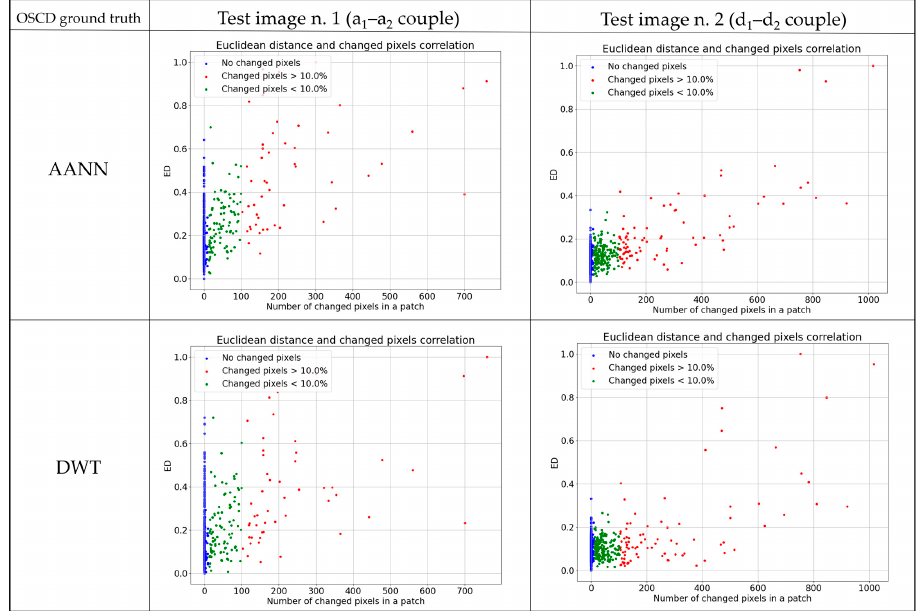
Figure 13. Correlation between the number of changed pixels in a ground truth patch ( x -axis) and the corresponding ED value ( y -axis) for the test images 1 in Figure 11a 1 ,a 2 ( left ) and the test images 2 in Figure 11d 1 ,d 2 ( right ). Each marker is colored according to the change condition in the OSCD ground truth